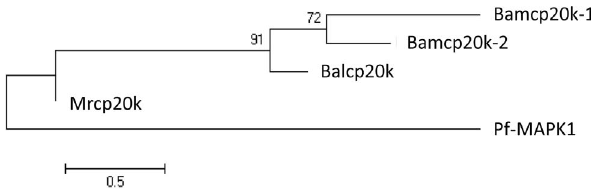
Figure 3. Phylogenetic tree analysis of cp20k. The full-length of the amino acid sequences were used in an alignment for phylogenetic tree calculations. The numbers indicate the occurrences of a branch point over 500 replications. The scale bar indicates the phylogenetic distances. Pf-MAPK1 was used as an out group protein.